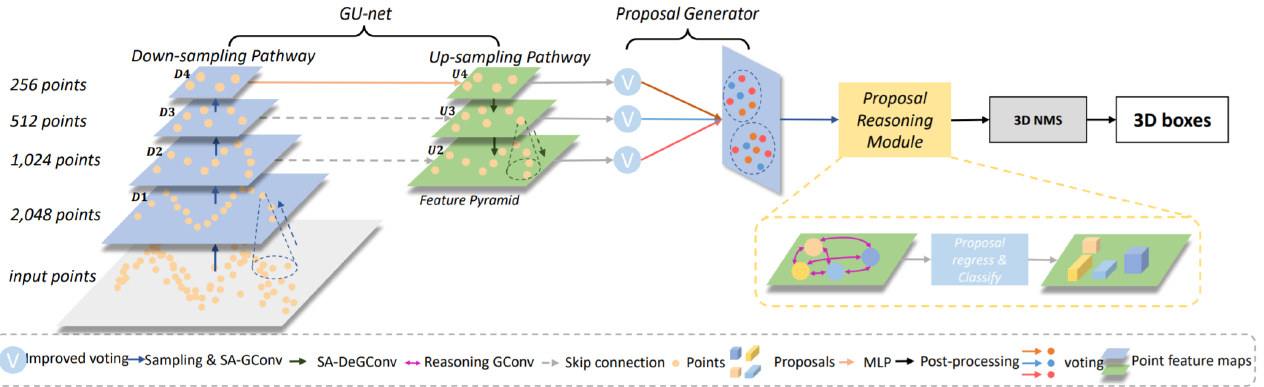
Figure 18. 3D object detection pipeline of HGNet [71] framework with three main components: GU-net, Proposal Generator, and ProRe